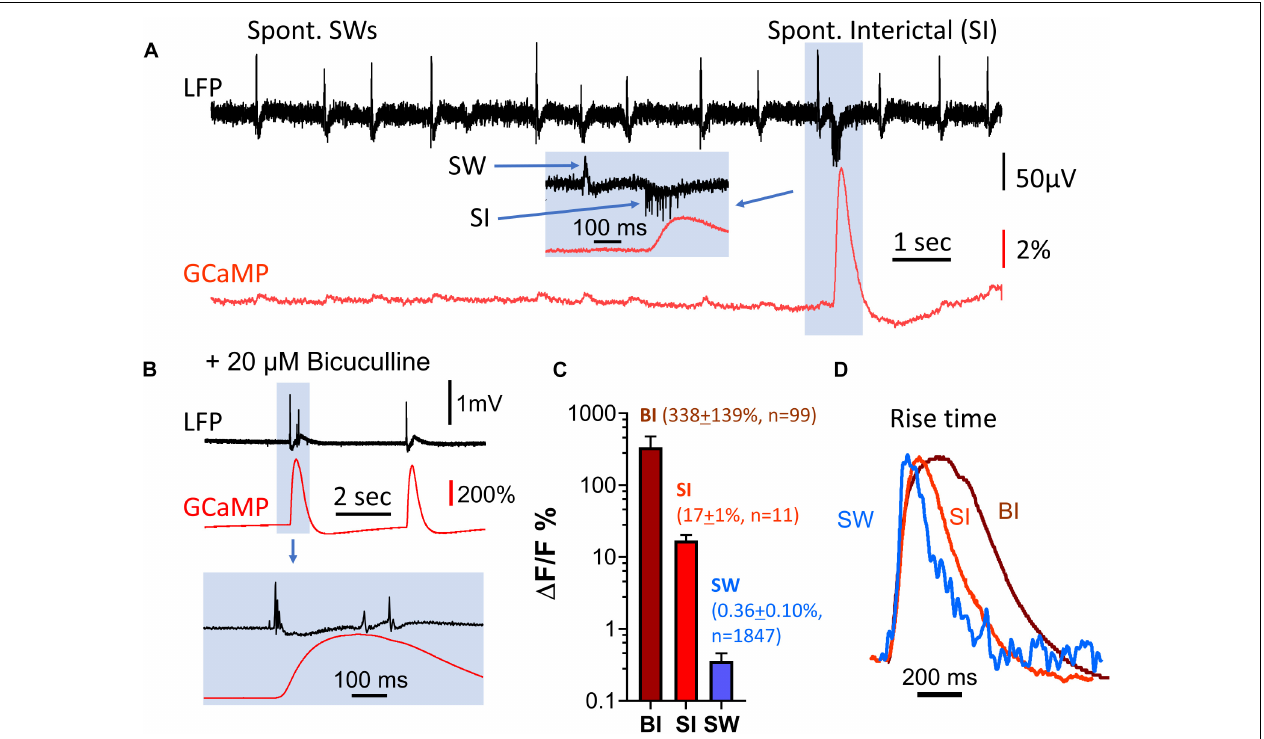
FIGURE 4 | Amplitude discrepancy between LFP and GCaMP signals during interictal-like events. (A) Spontaneous interictal events (blue box) rarely occur in healthy slices, and are associated with a low LFP peak amplitude but disproportionally large GCaMP fluorescence. The GCaMP signal was measured from the CA1 area, in a region of interest approximately 0.1 mm in diameter surrounding the location of the LFP electrode. Inset (blue box) : expanded time scale of the event, showing cellular spiking and the LFP peak of the interictal event. (B) Interictal-like events induced by bath supply of 20 µ M bicuculline. Bottom traces display event highlighted in blue box above on expanded time scale. (C) Comparison of GCaMP6f (cid:49) F / F amplitude for three types of events. BI: bicuculline-induced interictal-like spike, average (cid:49) F / F = 338 (SD 139%, n = 99 events from four slices from four animals). SI: spontaneous interictal event, average (cid:49) F / F = 17% (SD 1%, n = 11 events from one slice from one animal), SW: sharp wave, average (cid:49) F / F = 0.36% (SD 0.10%, n = 1847 events from the same slice with SIs). Error bars indicate SD. (D) Rise time of sharp wave (SW), spontaneous interictal events (SI) and bicuculline-induced interictal-like spikes (BI). The amplitude of the three events differ by a factor of ∼ 600 but have similar initial rise times. Note that the decay time of the three events are different. These traces are averages of n = 100 SWs from one animal; n = 11 SIs from the same animal; n = 10 BIs from a different